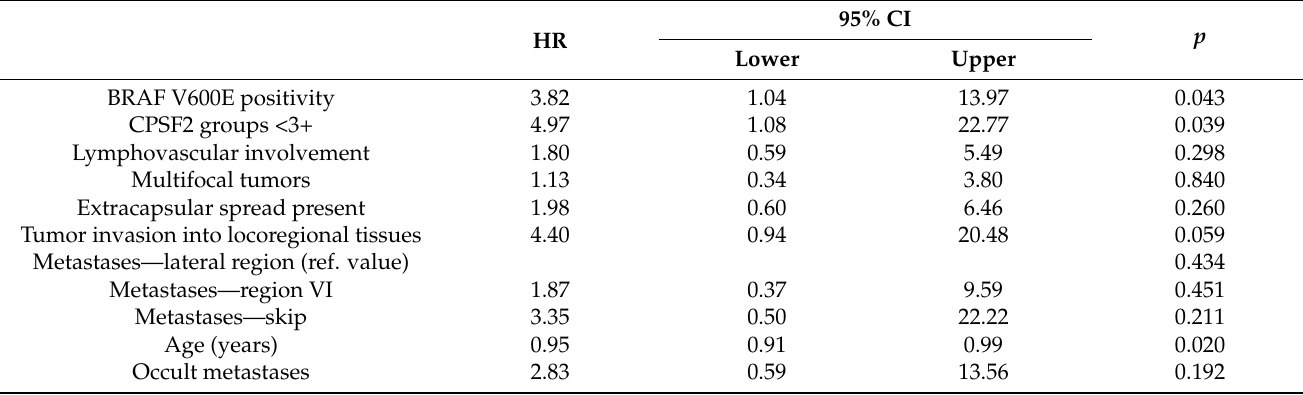
Table 3. Multivariate analysis for the recurrence prediction: Cox proportional hazards regression